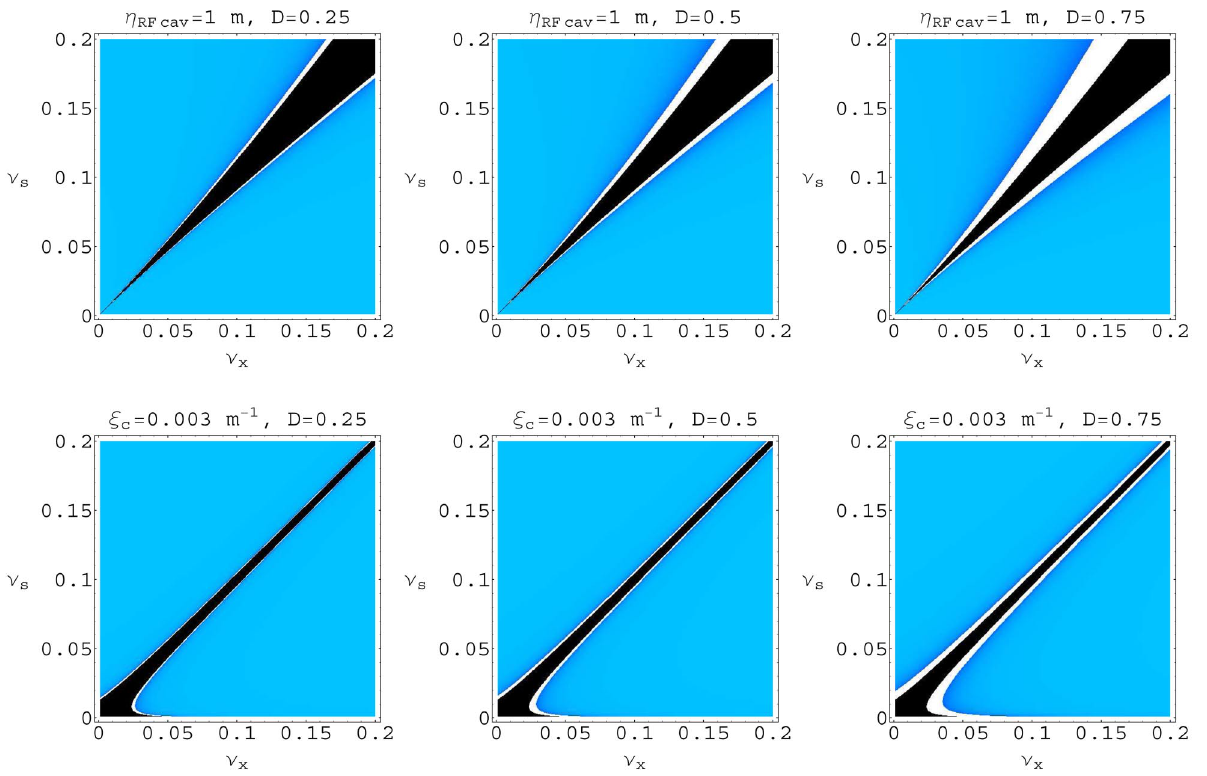
FIG. 7. (Color) Damping decrement near sum resonance for coupling due to a dispersive rf cavity (upper plots) and a crab cavity (lower plots). The black region represents an instability in the Hamiltonian dynamics, whereas the white area represents a negative and hence an antidamping instability. We vary the damping decrement D . In the two leftmost plots it is 0.25. For the center value of (cid:3) 1 near the sum resonance in Figs. 1 and 2 plot the same quantities, except that plots it is 0.5, and the right plots have 0.75. The plots of (cid:3) 1 and (cid:3) which widens the region where an in those cases, D (cid:14) 0 as discussed in the text. Increasing D increases the ratio of (cid:3) z x antidamping instability